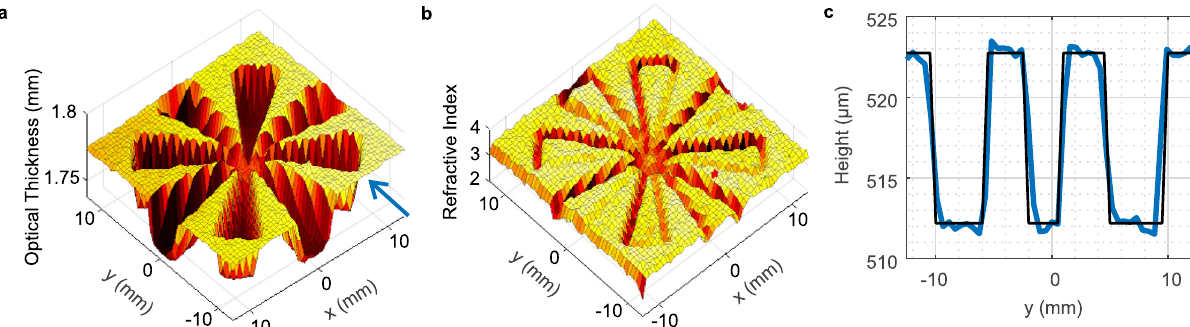
Fig. 2 Measurement of a 10 µ m etched Siemens star on silicon wafer. a 3D Terahertz image of a Siemens star with a depth of 10.7 µ m etched into a 520 µ m thick silicon wafer. The vertical axis shows the optical thickness. b 3D image of the refractive index of the silicon Siemens star. c Extracted physical thickness of the silicon Siemens star for a cut along the line x ¼ 8 mm indicated by the blue arrow in ( a ). NATURE COMMUNICATIONS| (2021) 12:7091